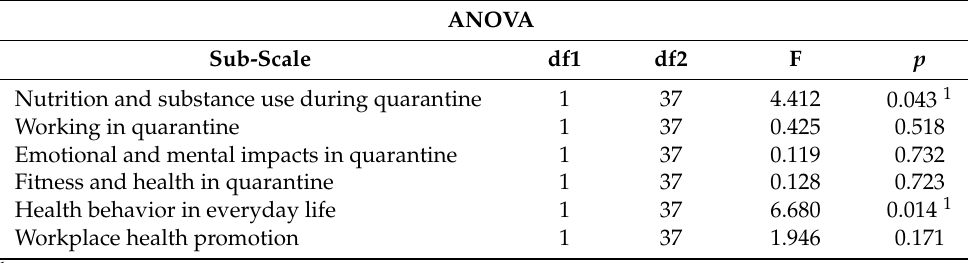
Table 9. Results of analysis of